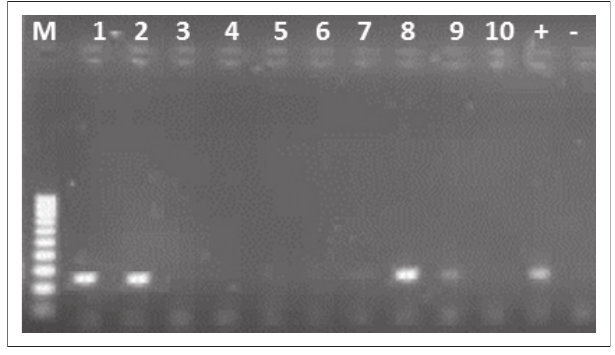
FIGURE 1: Gel electrophoresis of Anaplasma phagocytophilum polymerase chain reaction. Amplified polymerase chain reaction product with amplicon size of 250 bp.